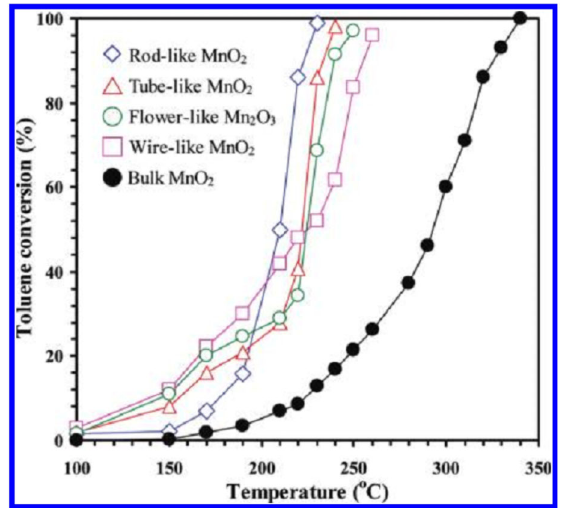
Figure 14. SEM images of ( a , b ) rod-like MnO 2 , ( c , d ) wire-like MnO 2 , ( e , f ) tube-like MnO 2 , and ( g , h ) flower-like Mn 2 O 3 . Reprinted with permission from Ref. [101]. Copyright 2012 American Chemical Society.